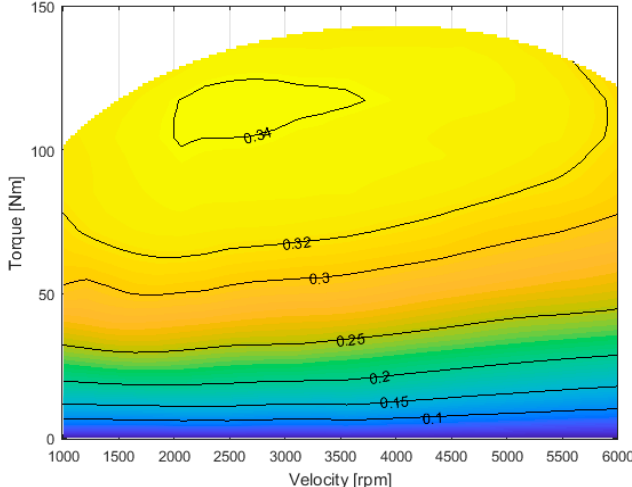
Figure 5. ICE efficiency contour map.